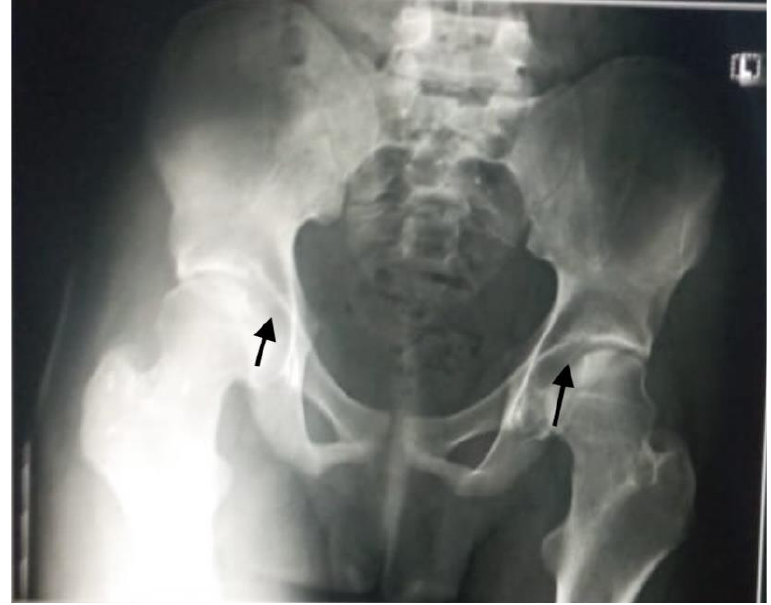
Figure 5. Plain radiograph showing avascular necrosis of the bilateral femoral head (black arrows). Commonly seen in sickle cell disease patients due to poor blood circulation from the disease condition.